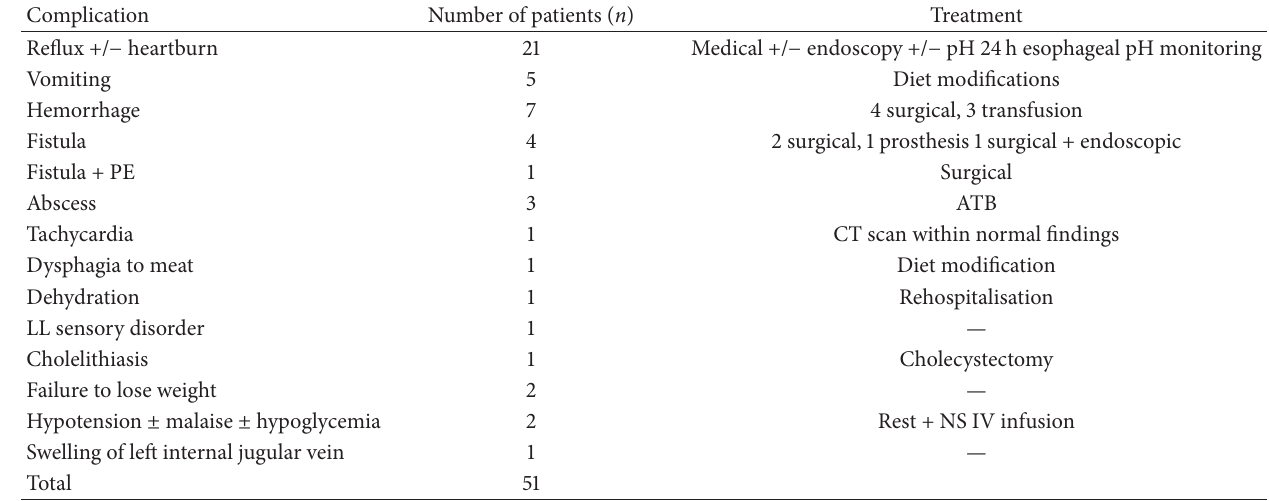
Table 2: Complications other than DS after